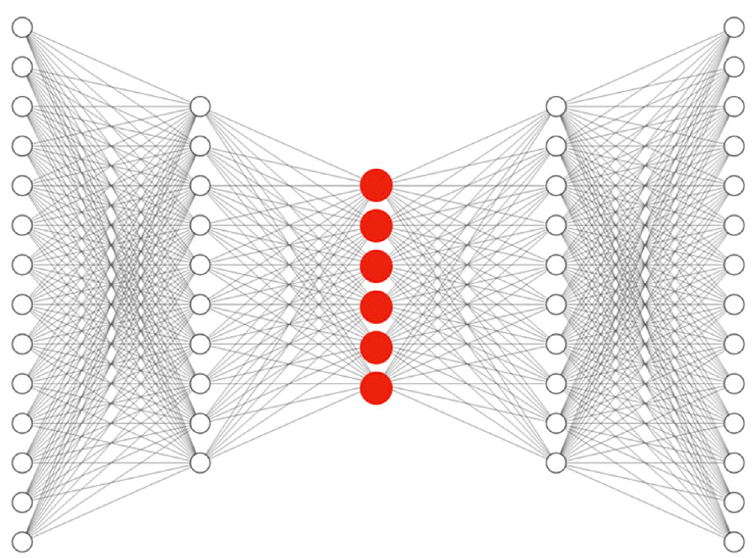
Fig 12. Simple classification network architecture. New representation from the classification task to feed into the pipeline is created by passing through the trained network and picking the red layer.